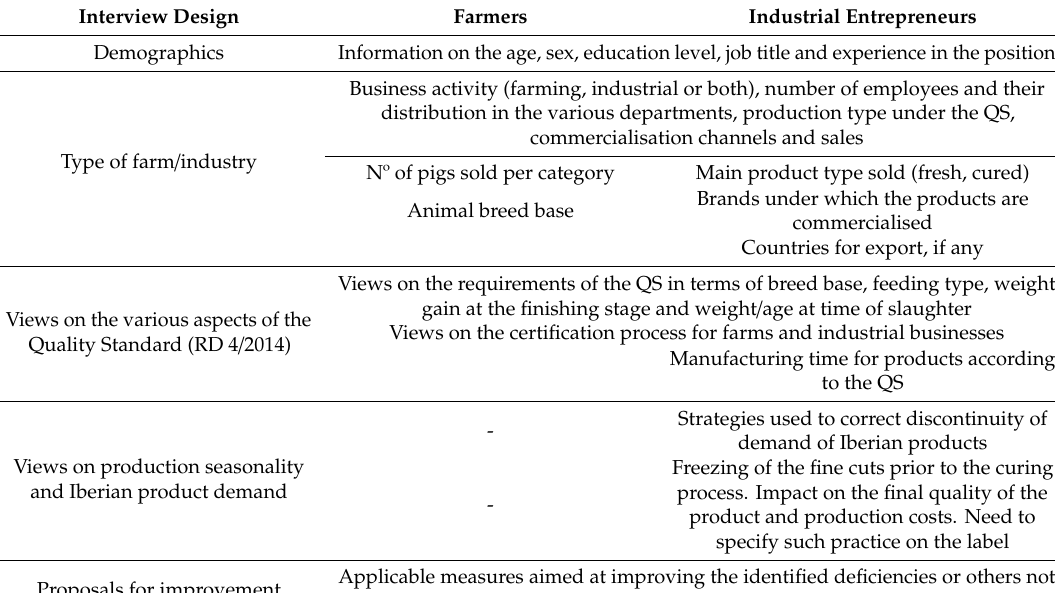
Table 2. Script of the interviews conducted with farmers and industrial